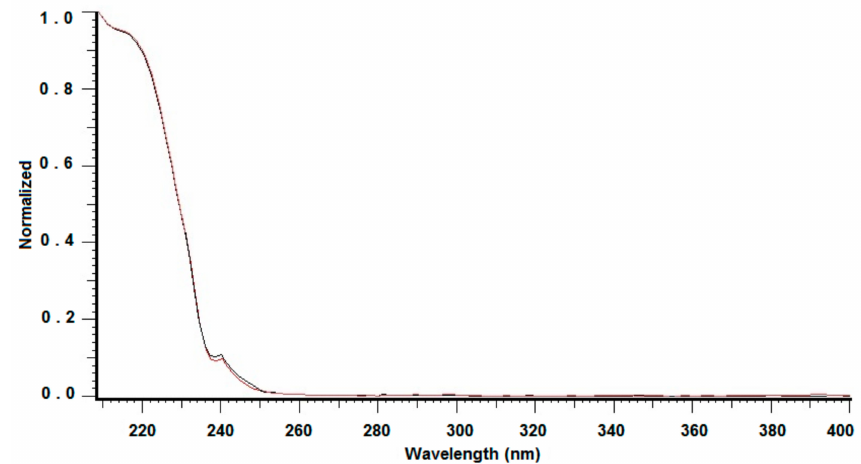
Figure 4. The SCN − peak identification by spectral matching. The red line represents standard and the black line represents investigated